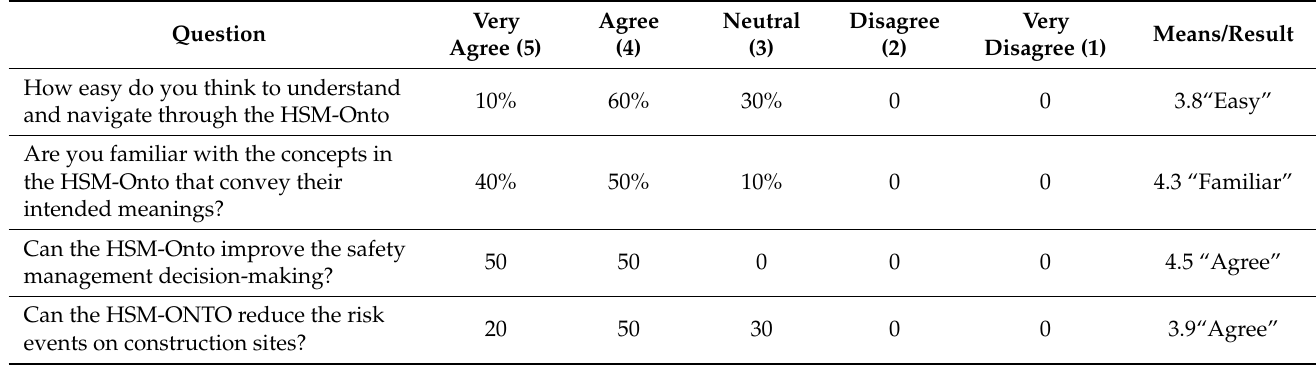
Table 3. Questionnaire made for the ontology semantic validation.